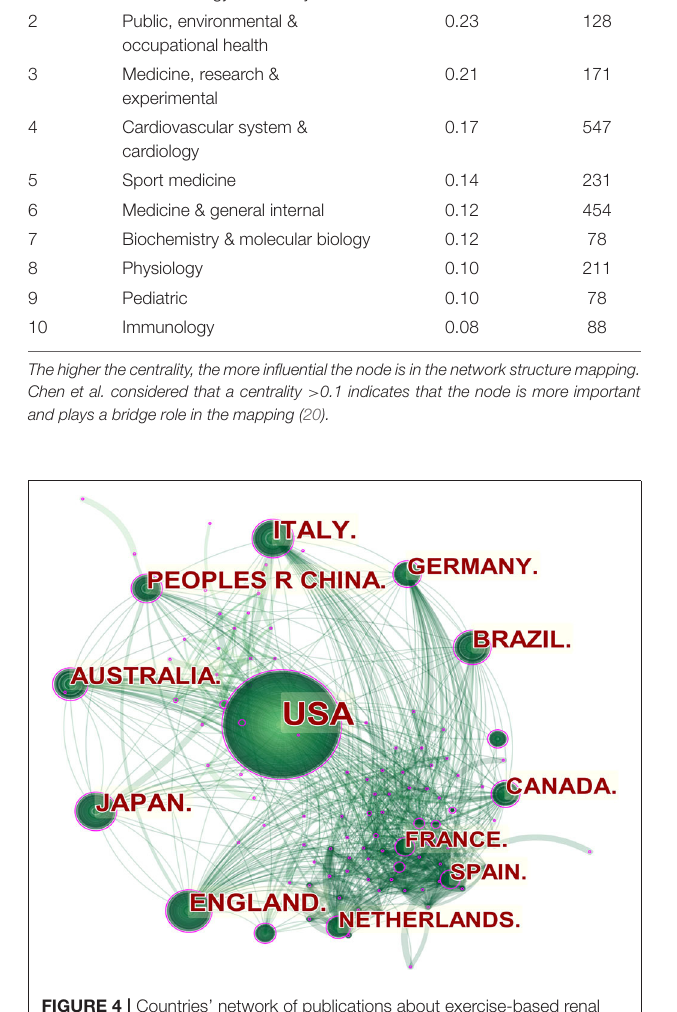
FIGURE 4 | Countries’ network of publications about exercise-based renal rehabilitation. Circled nodes represent output countries; connections between nodes indicate cooperative relationships.